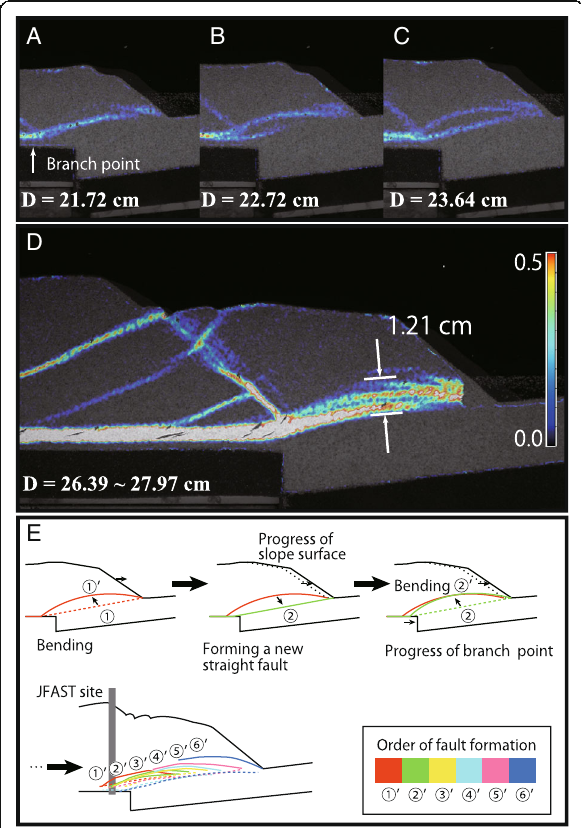
– c Continuous deformation of dancing. The white arrow indicates the branch point (McClay 1992). When the fault grows longer, it evolves into an anastomosing structure, as observed in stage 3 of Fig. 4. d The fault activity during dancing and the accumulated shear strain (100 s =20 image frames) of EXP 2 during the stage 3. The accumulated shear strain becomes larger in the order from blue to red in the color reference. Incremental shear strain indicates relative, not absolute, quantity. e Schematic diagrams of the fault dancing with the comparison of the JFAST site. Convex upward deformation of the fault is gradual, then the fault abruptly passes down to become a straight